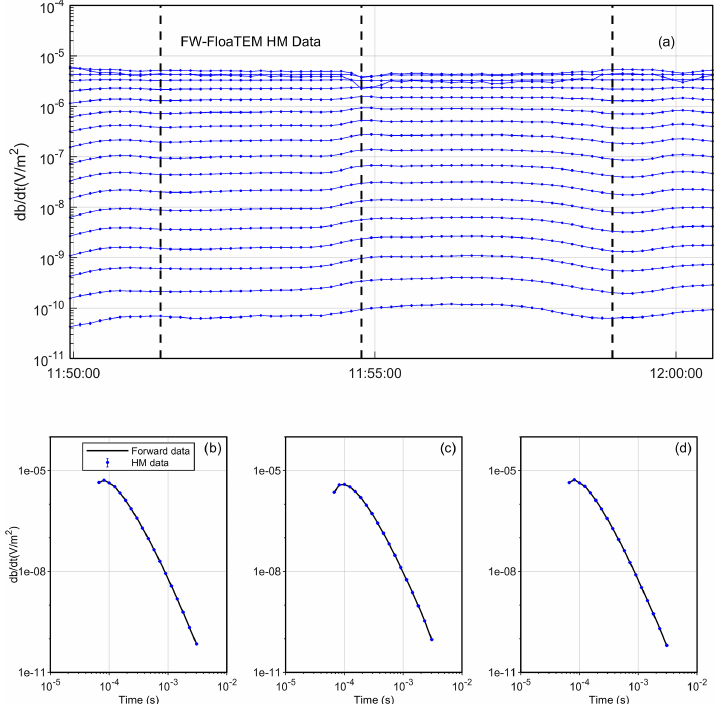
Figure A2. An example of data acquired using the SW-FloaTEM system. Panel (a) shows the data in profile view where each profile represents a gate; panels (b–d) show the transient decays shown, respectively, at three times marked as three vertical black dashed lines in (a)